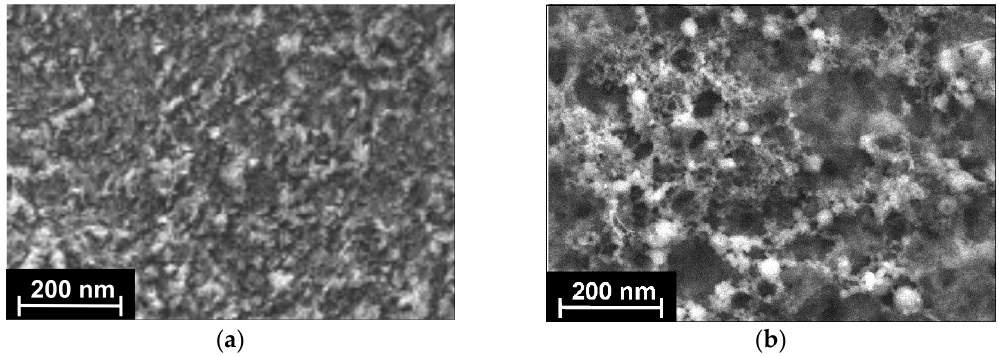
Figure 3. SEM images of the GCE surface covered with the CB cast from a 1.35 mg/mL suspension in 0.1 M HCl containing 0.278% chitosan, 2 μ L per electrode ( a ) prior to and ( b ) after deposition of the OLA- cone /aptamer mixture (1:2).